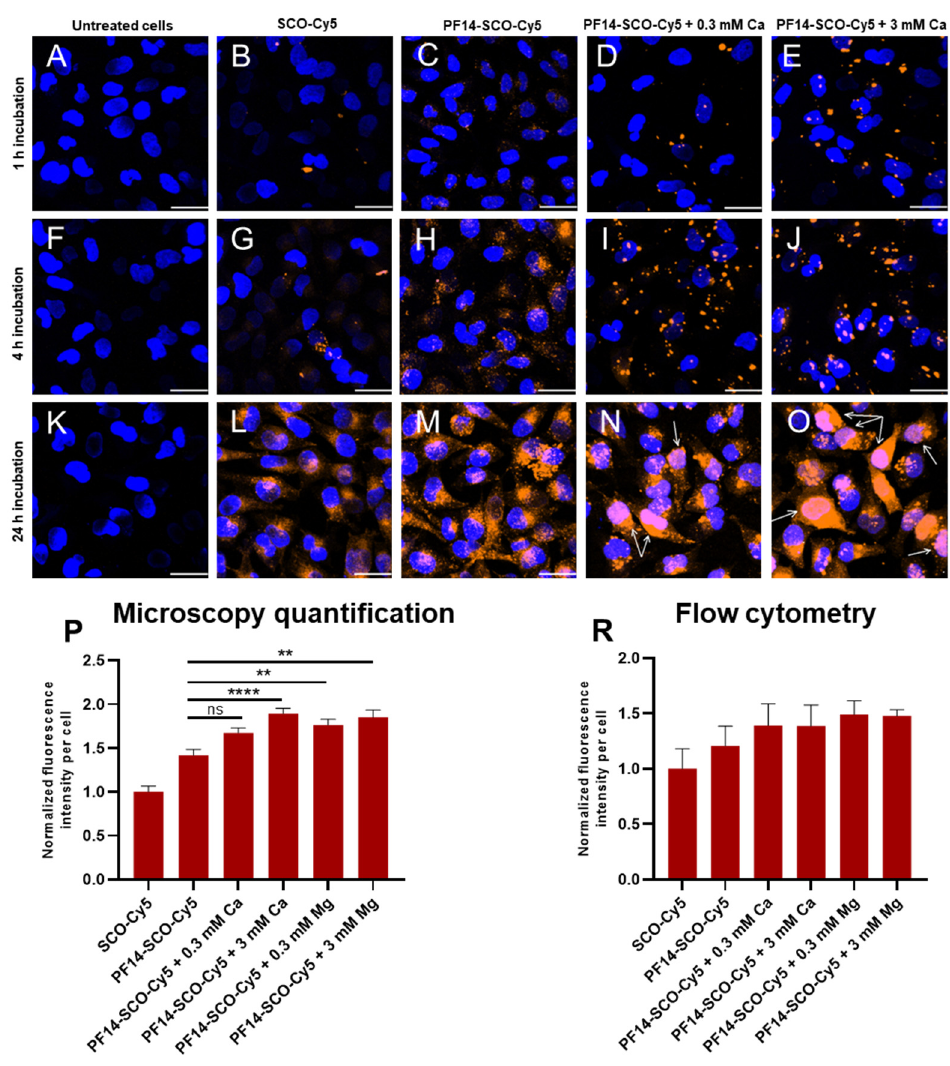
Figure 3. Delivery of splice-correcting oligonucleotide into HeLa cells with PF14 nanoparticles containing calcium ions. HeLa pLuc 705 cells were left untreated ( A , F , K ) or were incubated with 100 nM SCO-Cy5 ( B , G , L ), nanoparticles of 100 nM SCO-Cy5 and 500 nM PF14 ( C , H , M ) or same nanoparticles prepared with addition of 0.3 mM Ca 2+ ( D , I , N ) or 3 mM Ca 2+ ( E , J , O ). Cells were incubated with the solutions for 1 ( A – E ), 4 ( F – J ) or 24 h ( K – O ), fixed, and localization of SCO by Cy5 fluorescence (orange signal) was analyzed with Olympus FluoView FV1000 (Olympus, Tokyo, Japan) confocal microscope. Cell nuclei were visualized with DAPI (blue). Inclusion of Ca ions into PF14-SCO nanoparticles led to distribution of SCO-Cy5 to cytosol and nucleus of cells (with arrows on ( L , O )). The merged images of all confocal planes are presented. One representative of three independent experiments is presented. Scale bar 30 μ m. Panel ( P ): Cy5 signal of at least 100 cells per sample was quantified using AutoQuant X3 software. Panel ( R ): alternatively, flow cytometry analysis was performed to analyze association and internalization of PF14-SCO-Cy5 nanoparticles after 24 h, using BD FACSAria Cell Sorter (BD Biosciences, Franklin Lakes, NJ, USA). In flow cytometry, 30,000 events per sample were detected, and each experiment was performed at least 3 times. All values are normalized against average fluorescence intensity in the samples treated with SCO alone. Each dataset represents mean + SEM. Data was analyzed by one-way ANOVA with Tukey’s test, ** p -value < 0.005, **** p -value < 0.0001, ns—not